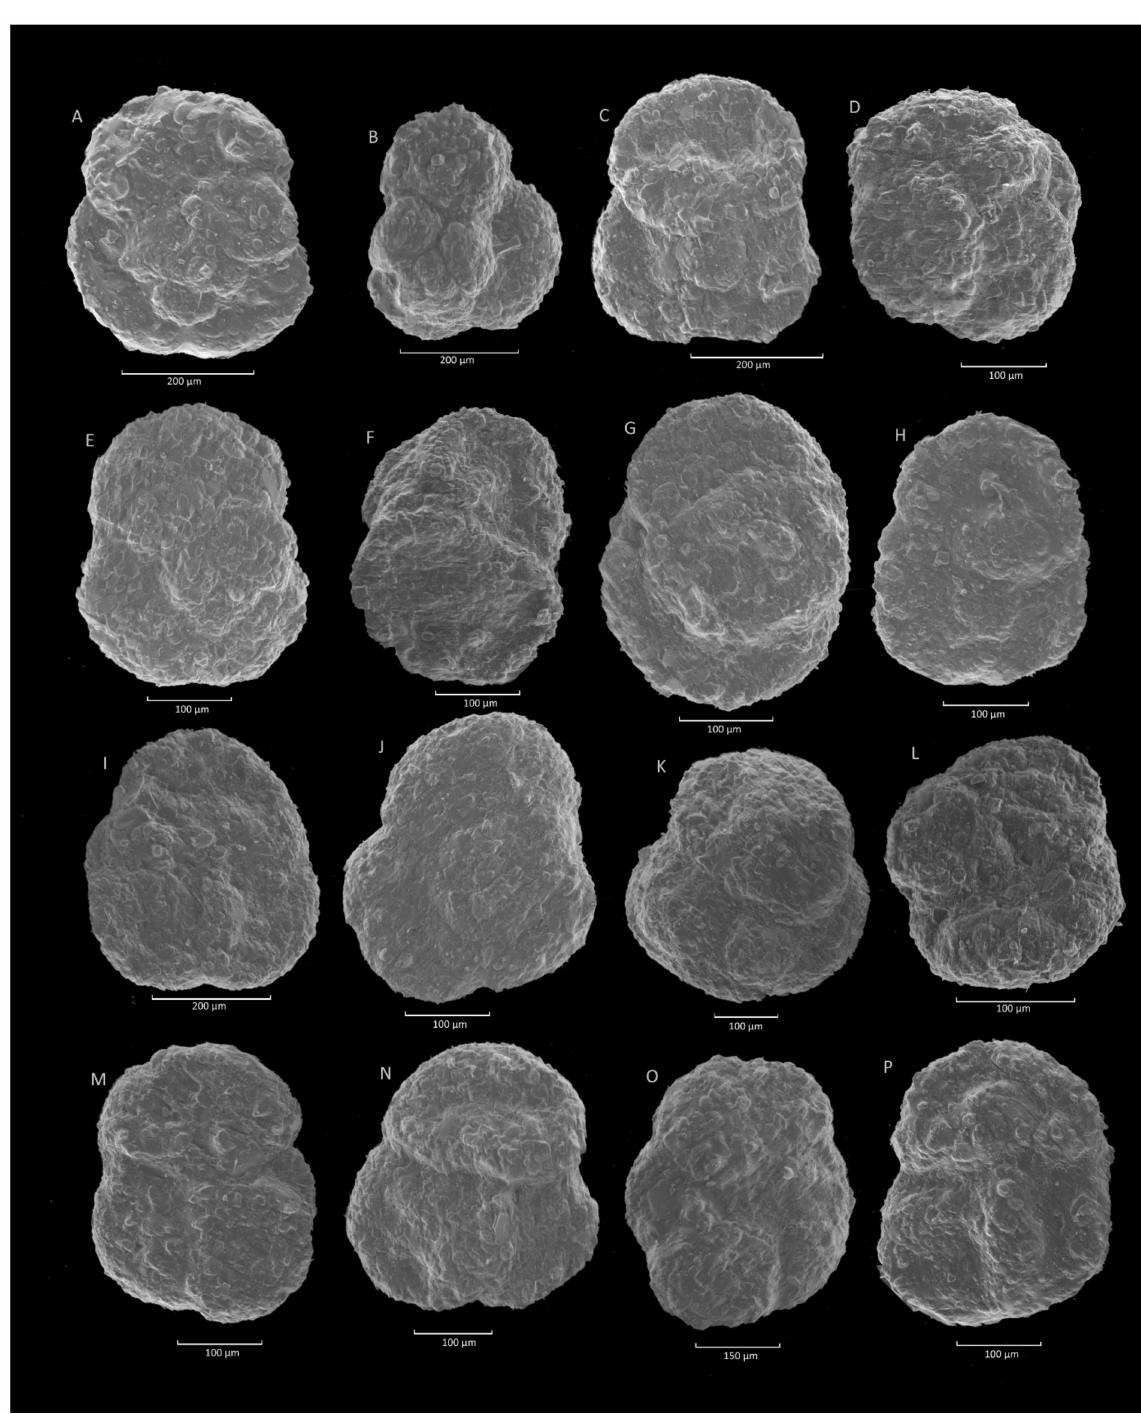
Figure 14. Trochammina sp. ( A – C , E ): Krzesławice section; ( D , F – J , M , O ): Janoska section; ( K , L , N , P ): Stradomka